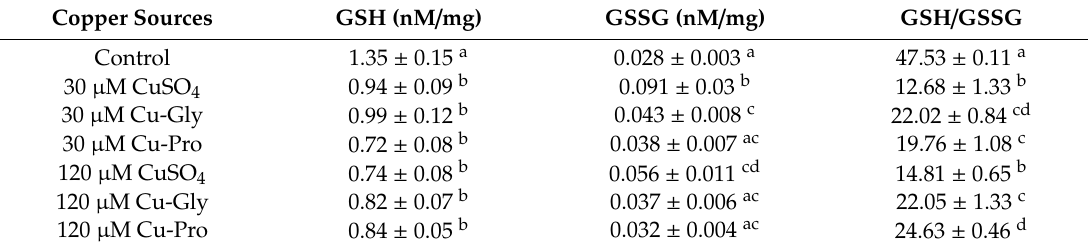
Table 2. Reduced and oxidized glutathione (GSH and GSSG) levels in IPEC-J2 cells determined by LC-MS / MS ( n = 3). Cells were treated with CuSO 4 , Cu Glycine (Cu-Gly), and Cu proteinate (Cu-Pro) at the concentrations of 30 and 120 µ M for 10 h. Significant di ff erences between processing groups are represented by di ff erent lowercase letters ( p <